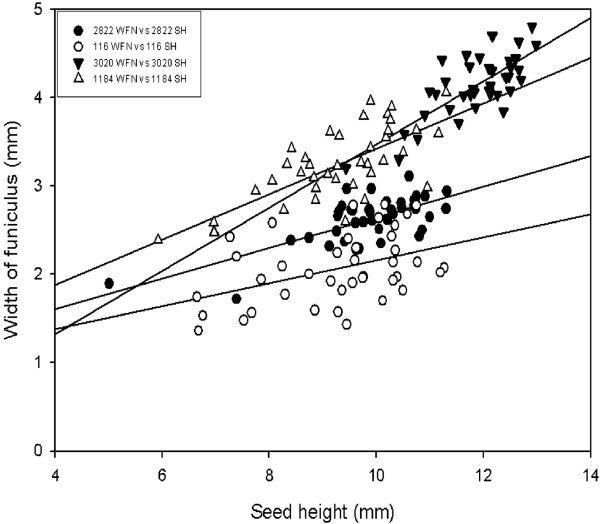
The relationship between seed height (SH) and width of funiculus (WFN) in the wild type and the def mutant Pisum sativum. Linear models were fitted to four data sets: JI 116 (Y = 0.855 + 0.131 X; R2 = 17.9%; P = 0.051), JI 2822 (Y = 0.909 + 0.173 X; R2 = 49.5%; P = 0.003), JI 1184 (Y = 0.851 + 0.257 X; R2 = 53.5%; P = 0.024), JI 3020 (Y = -0.114 + 0.359 X; R2 = 56.6%; P = 0.852).